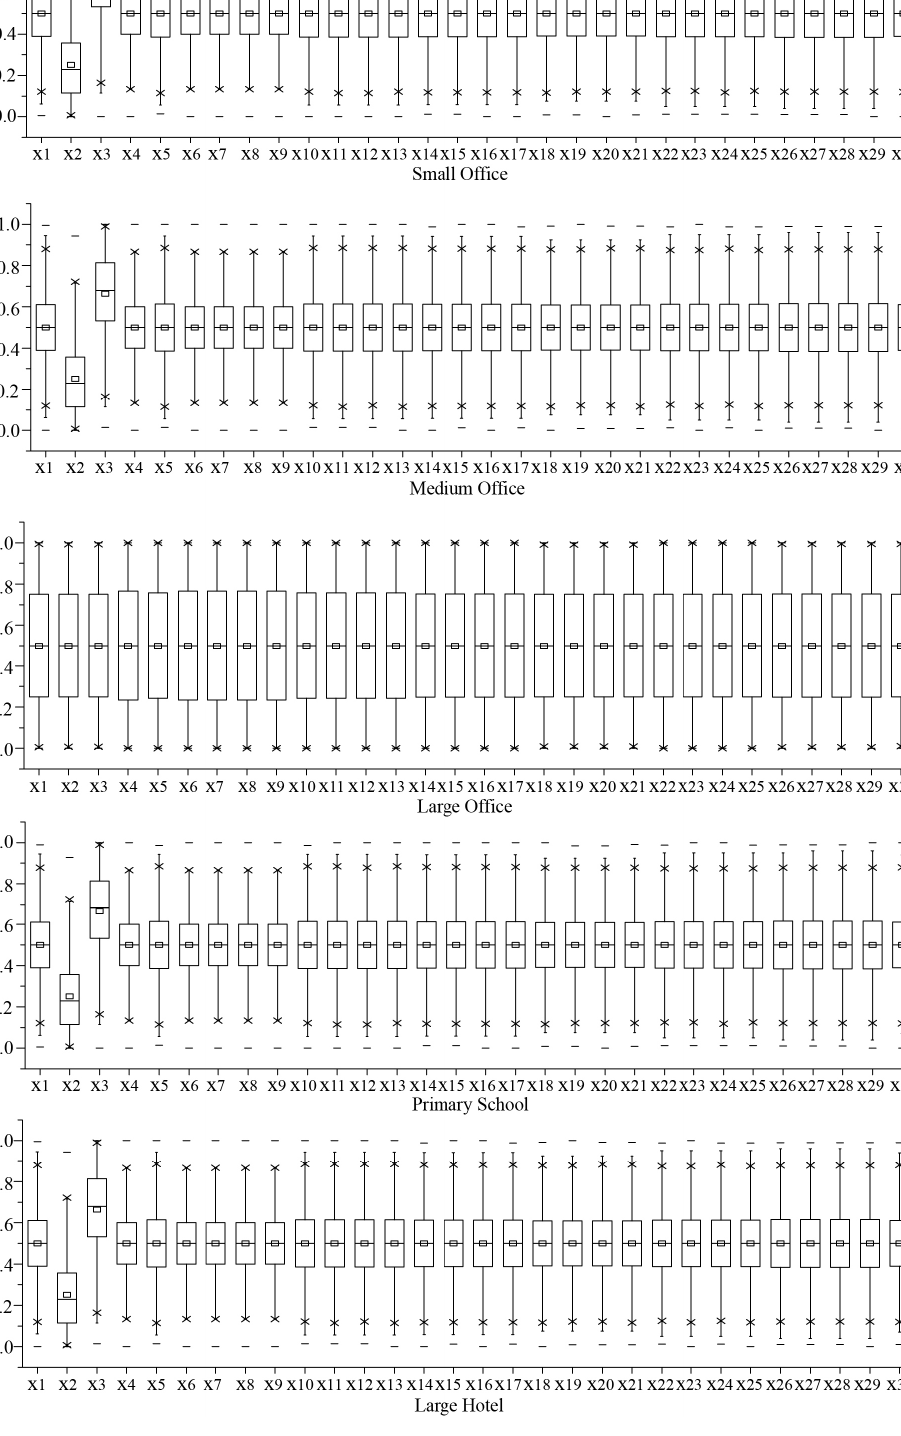
Figure 6. Sample d istribution of benchmark problems with 30 design variables. Figure 6. Sample distribution of benchmark problems with 30 design